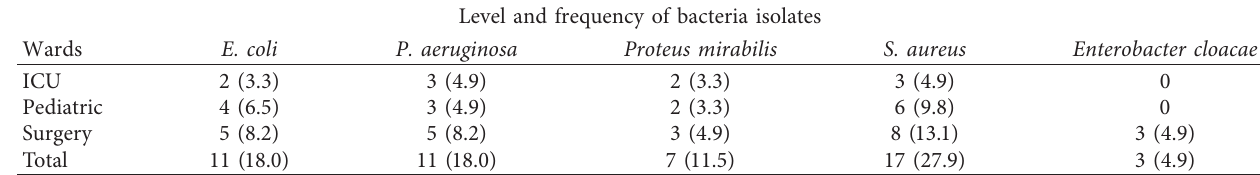
Table 4: Bacteriological contamination in the patient wounds.